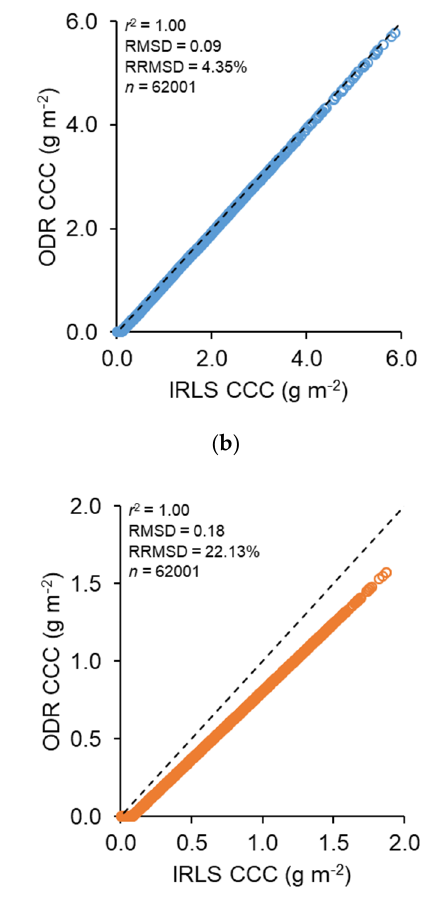
Figure 10. Comparison between high-spatial-resolution reference maps and in situ reference measurements of FIPAR ( left ) and CCC ( right ) for the Las Tiesas–Barrax ( a , b ) and Wytham Woods ( c , d ) campaigns. The dashed line represents a 1:1 relationship, whilst error bars represent expanded uncertainties at the k = 2 coverage interval.